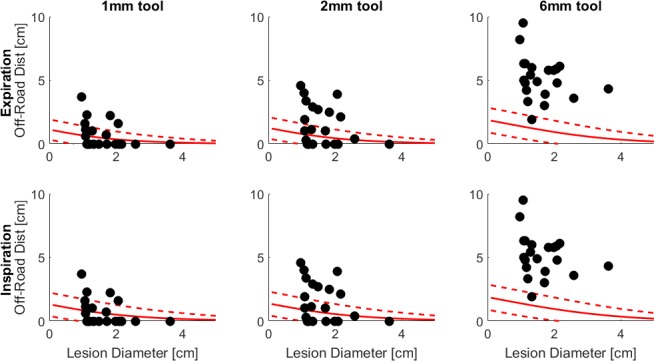
Distance a tool must travel off-road to reach a lesion in simulated model 1.The lines represent the average and standard deviations of the model. The black dots are the lesions measured from the CT scans.